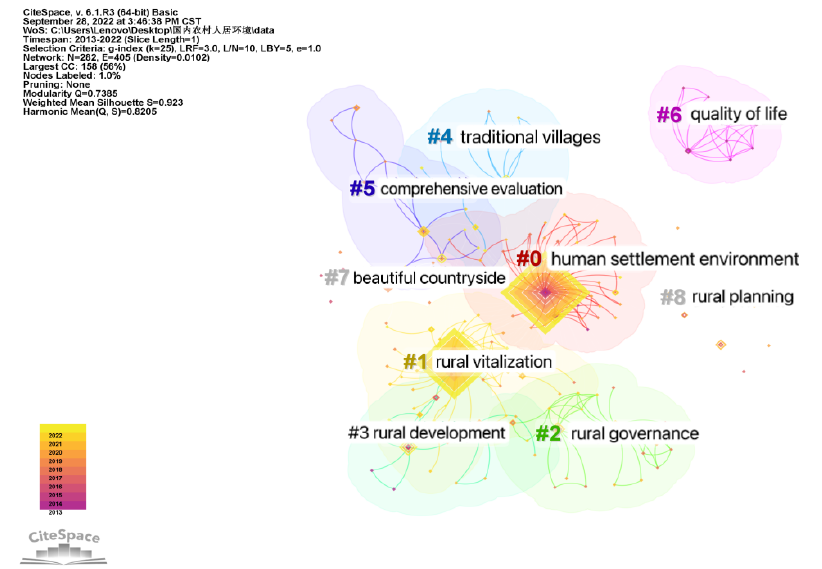
Figure 8. Keyword clustering of rural human settlement environment research.